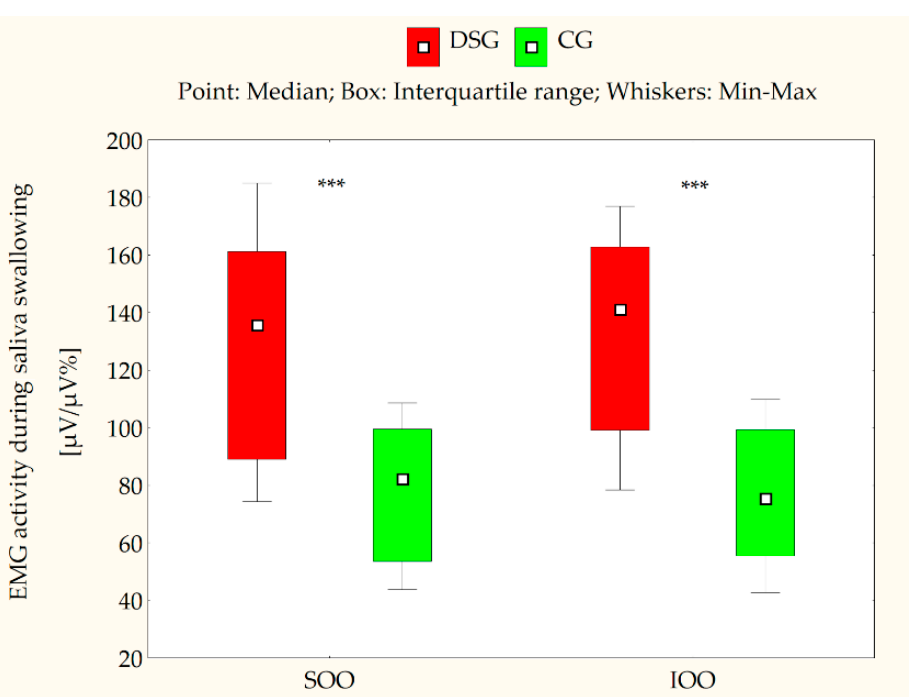
Figure 2. EMG activity of the superior orbicularis oris (SOO) and inferior orbicularis oris (IOO) muscles (µV/µV%) during saliva swallowing in the Down syndrome group (DSG) and the control group (CG); *** p < 0.001.